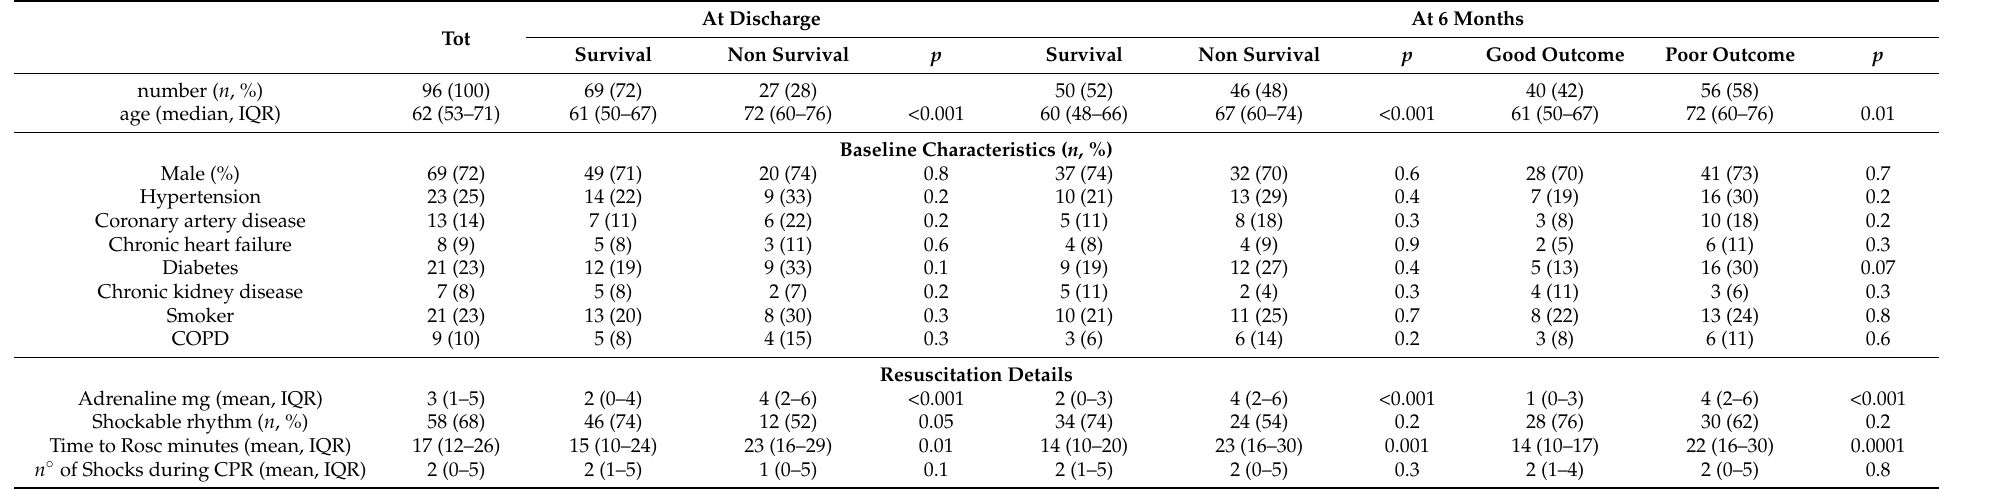
Table 1. Baseline characteristics and resuscitation